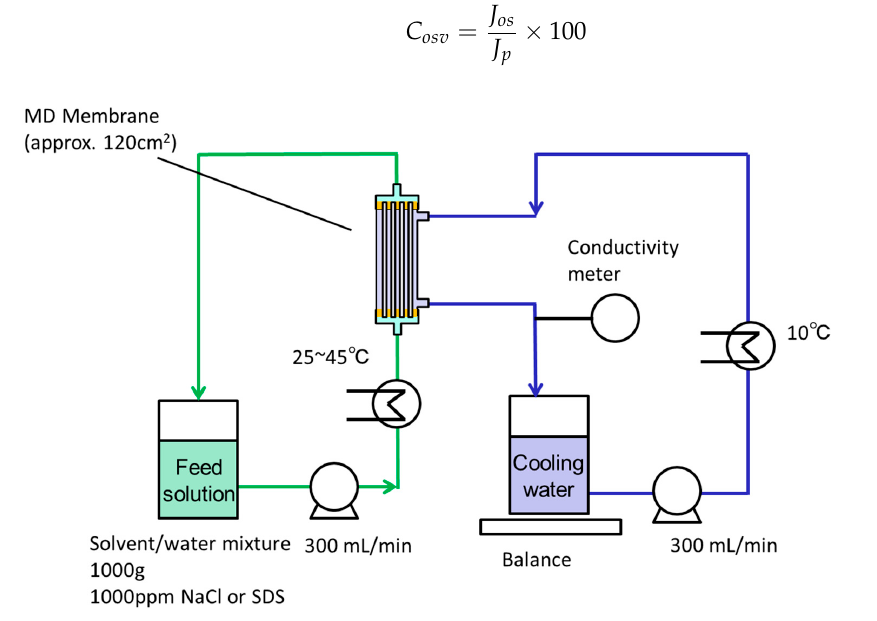
Figure 5. The schematic of DCMD system.